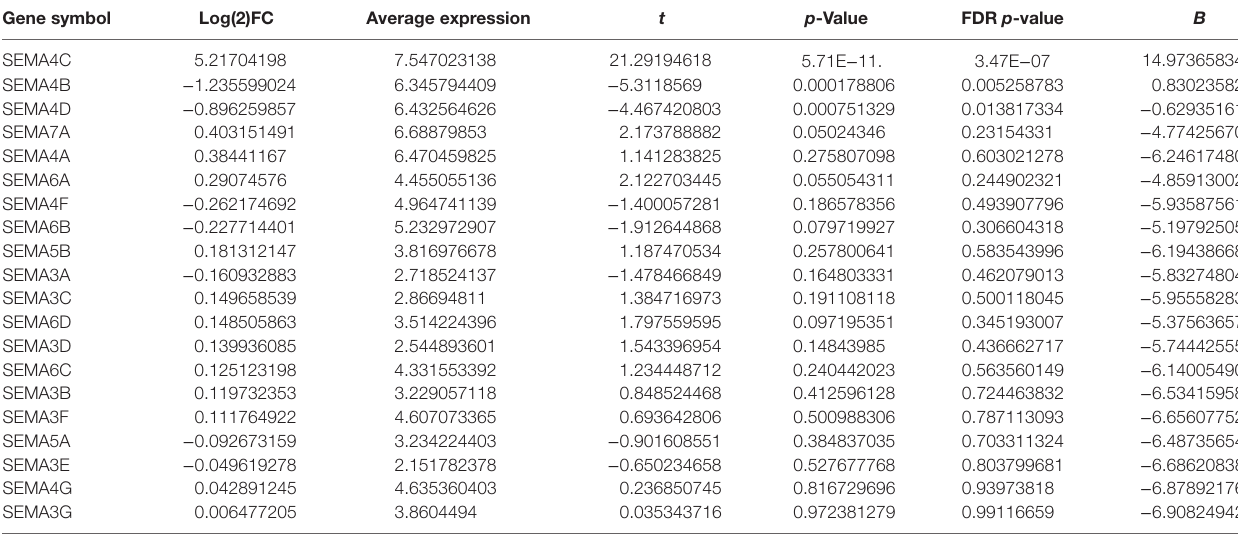
TaBle 2 | Differential expression of semaphorin family members.